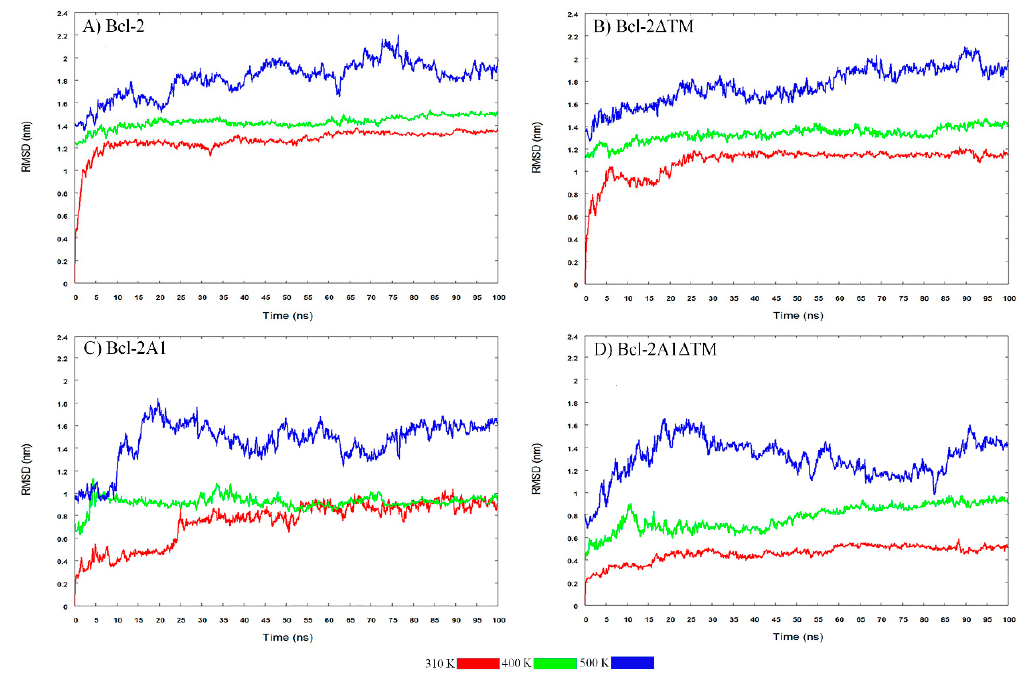
Figure 4. Time evolution of C- α root mean square deviations (RMSD) of ( A ) Bcl-2; ( B ) Bcl-2 Δ TM; ( C ) Bcl-2A1, and ( D ) Bcl-2A1 Δ TM. The color indicates the temperature of each molecular dynamic (MD) simulation, as stated.